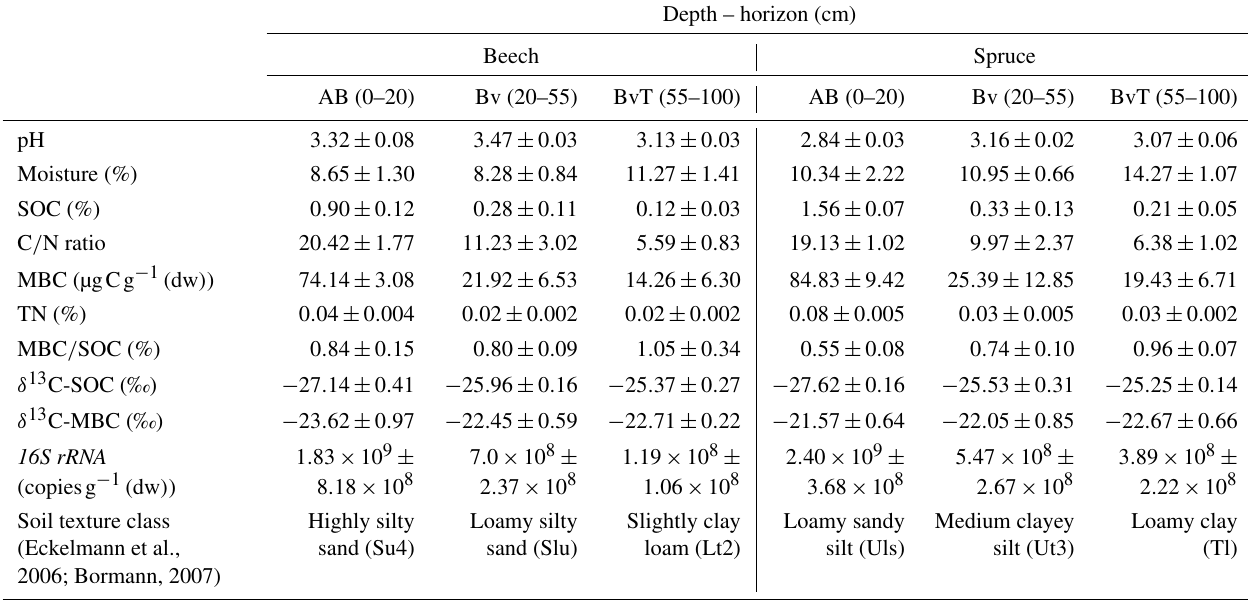
Table 1. Geochemical properties of soil cores obtained from beech and spruce soil plots at the Hummelshain forest. Soil pH, moisture content, soil organic carbon (SOC), carbon / nitrogen (C / N) ratio, microbial biomass carbon (MBC), total nitrogen (TN), MBC / SOC ratio, natural abundance of 13 C of SOC and MBC, bacterial abundance ( 16S rRNA gene copies), and soil texture class are reported for three depths definitions for the beech and spruce soils of the Hummelshain forest. Each reported value represents the mean of three replicate soil cores taken from bulk soils during the sampling campaign. The abbreviation “dw” denotes dry